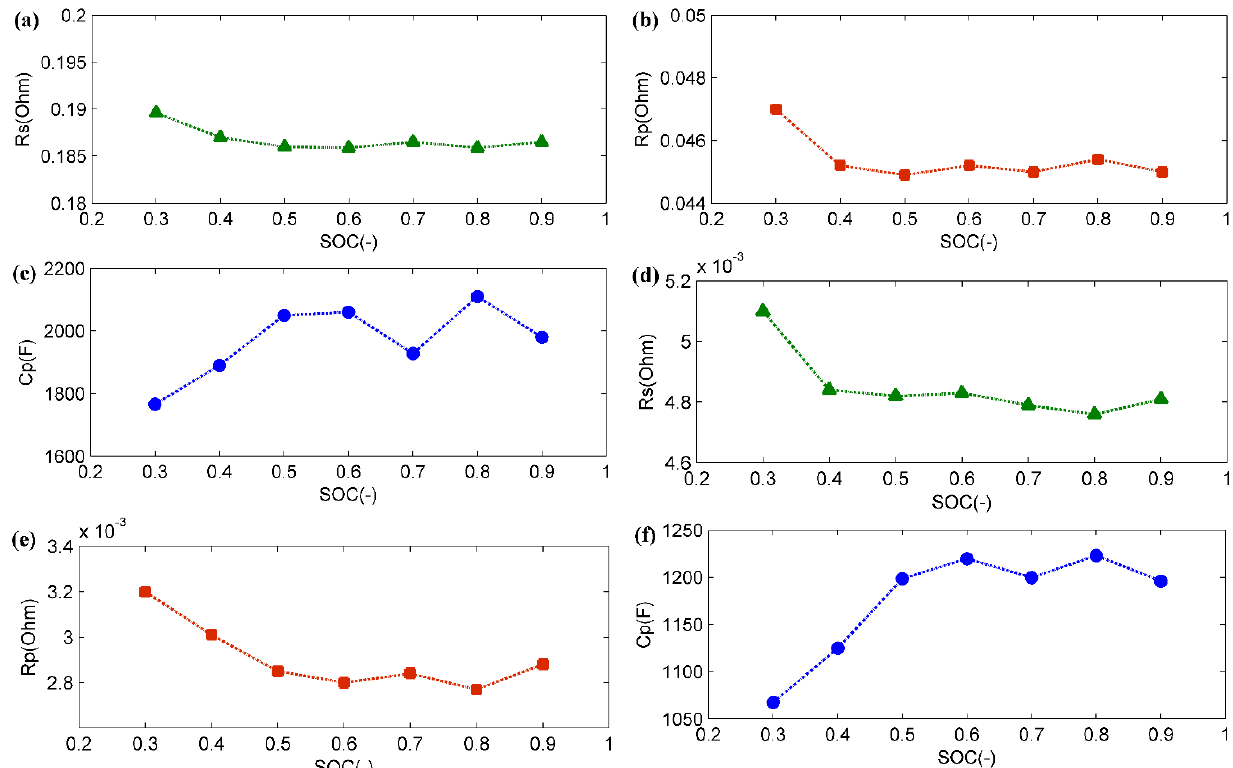
Figure 4. Parameters identification results: ( a ) R s results of LiCoO 2 (LCO) cell; ( b ) R p results of LCO cell; ( c ) C p results of LCO cells; ( d ) R s results of LiFePO 4 (LFP) cell; ( e ) R p results of LFP cell; ( f ) C p results of LFP